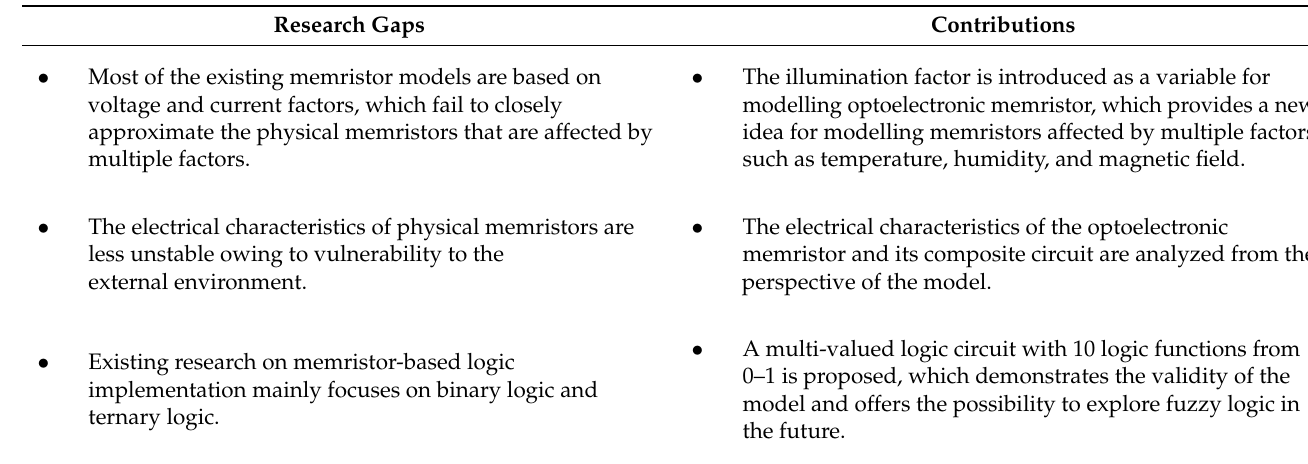
Table 1. The research gaps and the main